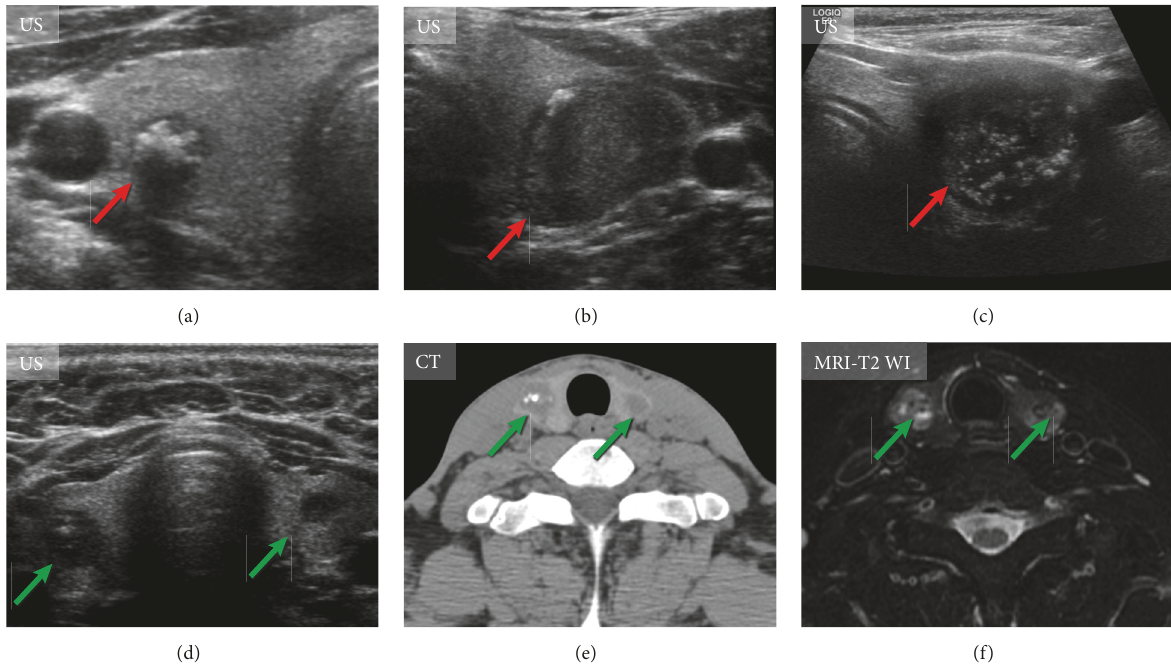
Figure 3: Imaging of the primary tumor in medullary thyroid carcinoma. (a)-(c) Ultrasound (US) features of primary medullary thyroid carcinoma of different patients (red arrows). US of the thyroid gland shows markedly hypoechoic nodules with marked calcifications. (d)- (f) US of the neck, computed tomography, and magnetic resonance tomography (T2 weighted images of the neck) of the same patient with bilateral medullary thyroid carcinomas (green